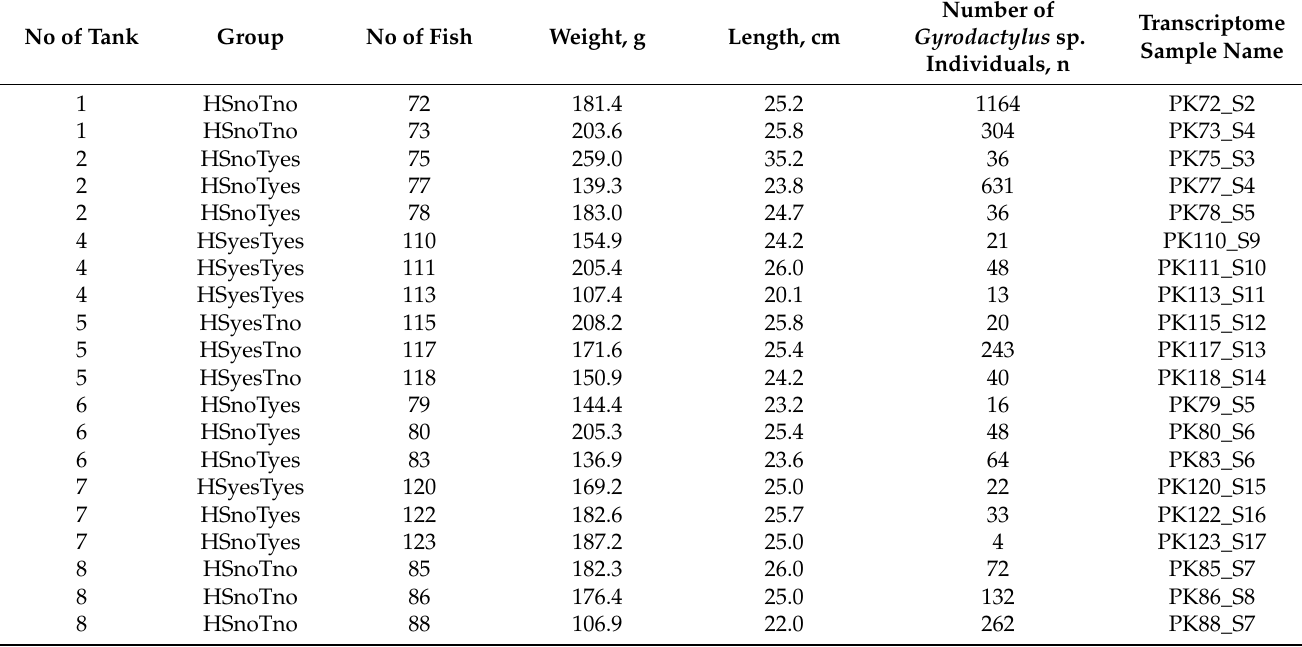
Table 1. Length–weight parameters and Gyrodactylus sp. infestation of rainbow trout individuals. For groups, the presence of heat stress (HS) and taxifolin (T) is indicated in group